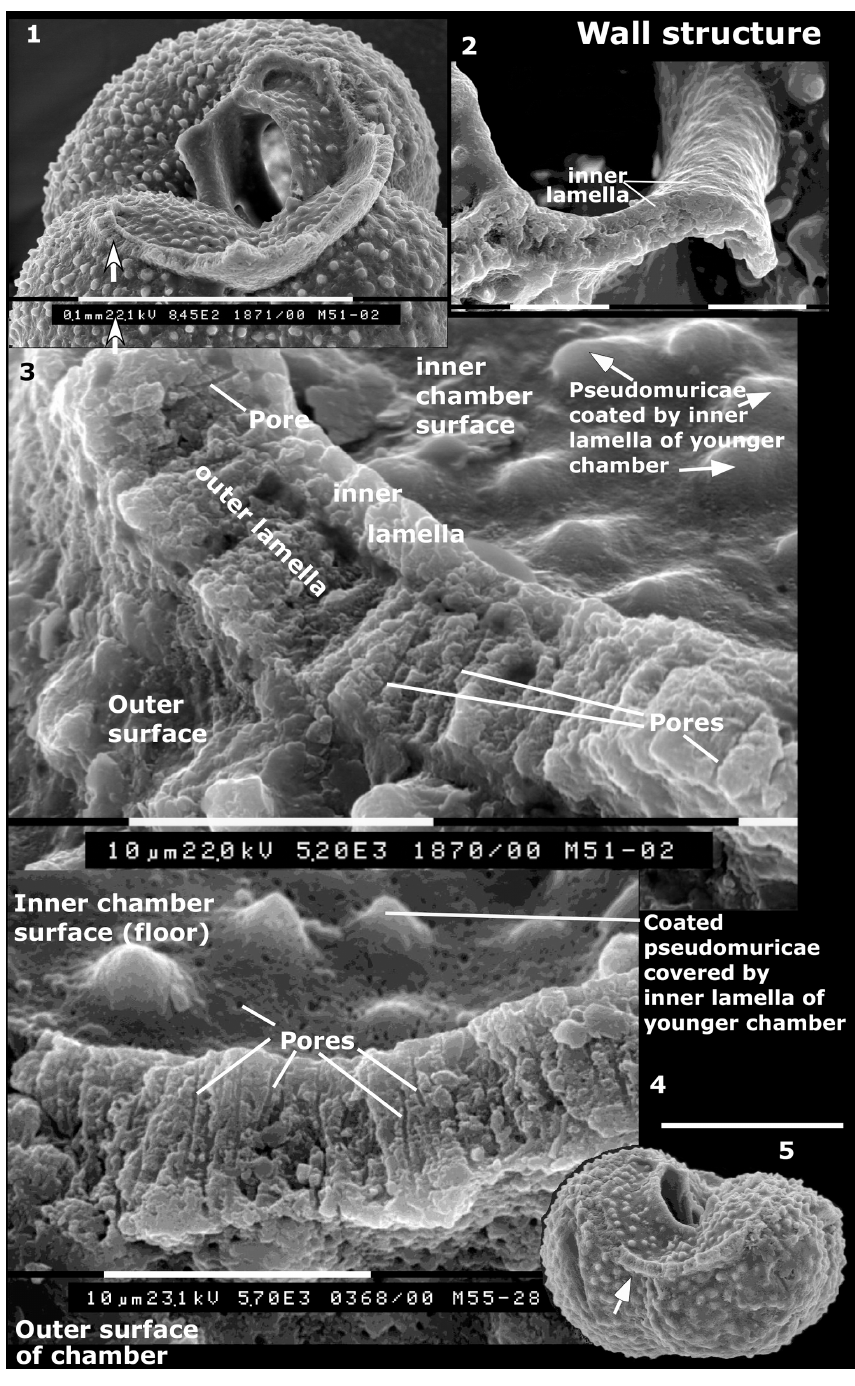
Figure 6. Wall structure (1–3) Globuligerina altissapertura n. sp., specimen WAM 18.9/M51-02; (1) side view of later chambers to show broken wall of final chamber and base of broken apertural lip of final chamber; scale bar: 100µm; (2) apertural lip of final chamber, seen from above. Note the inner lamella that appears to thicken as it bends into the curved edge of the lip. Each scale bar: 10µm. (3) Broken wall of the final chamber (location arrowed in 1 ) to show inner lamella coating the floor of the chamber, outer lamella and thin pores which appear to pass through both. Each scale bar: 10µm. (4–5) Globuligerina bathoniana australiana n. ssp., specimen WAM 18.18/M55-28; (4) detail of broken wall, showing well-developed pores and porous inner surface of chamber (at top) and outer surface of wall (at bottom). Scale bar for (4) : 10µm. (5) Whole specimen, side view to show wall location (lower arrow). Scale bar for (5) (above 5 ):